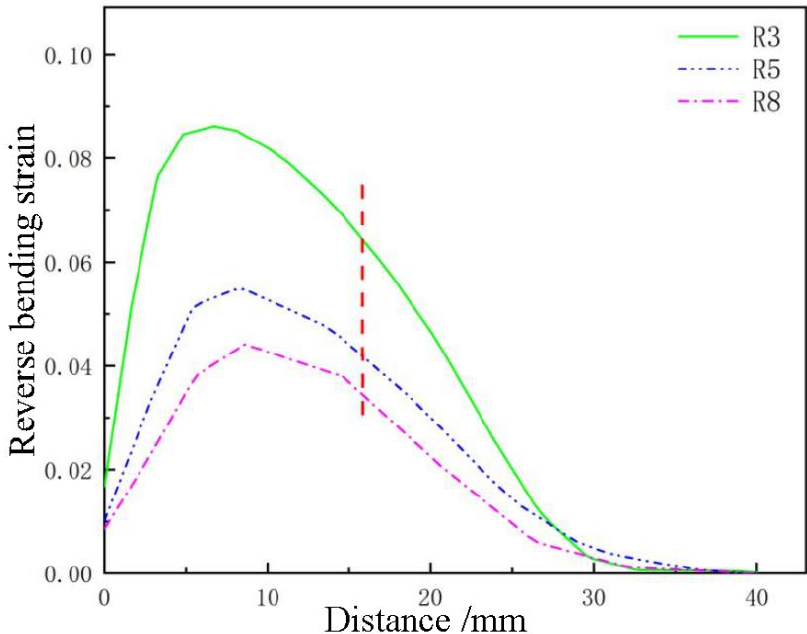
Figure 17. Reverse strain curves at different die fillets.